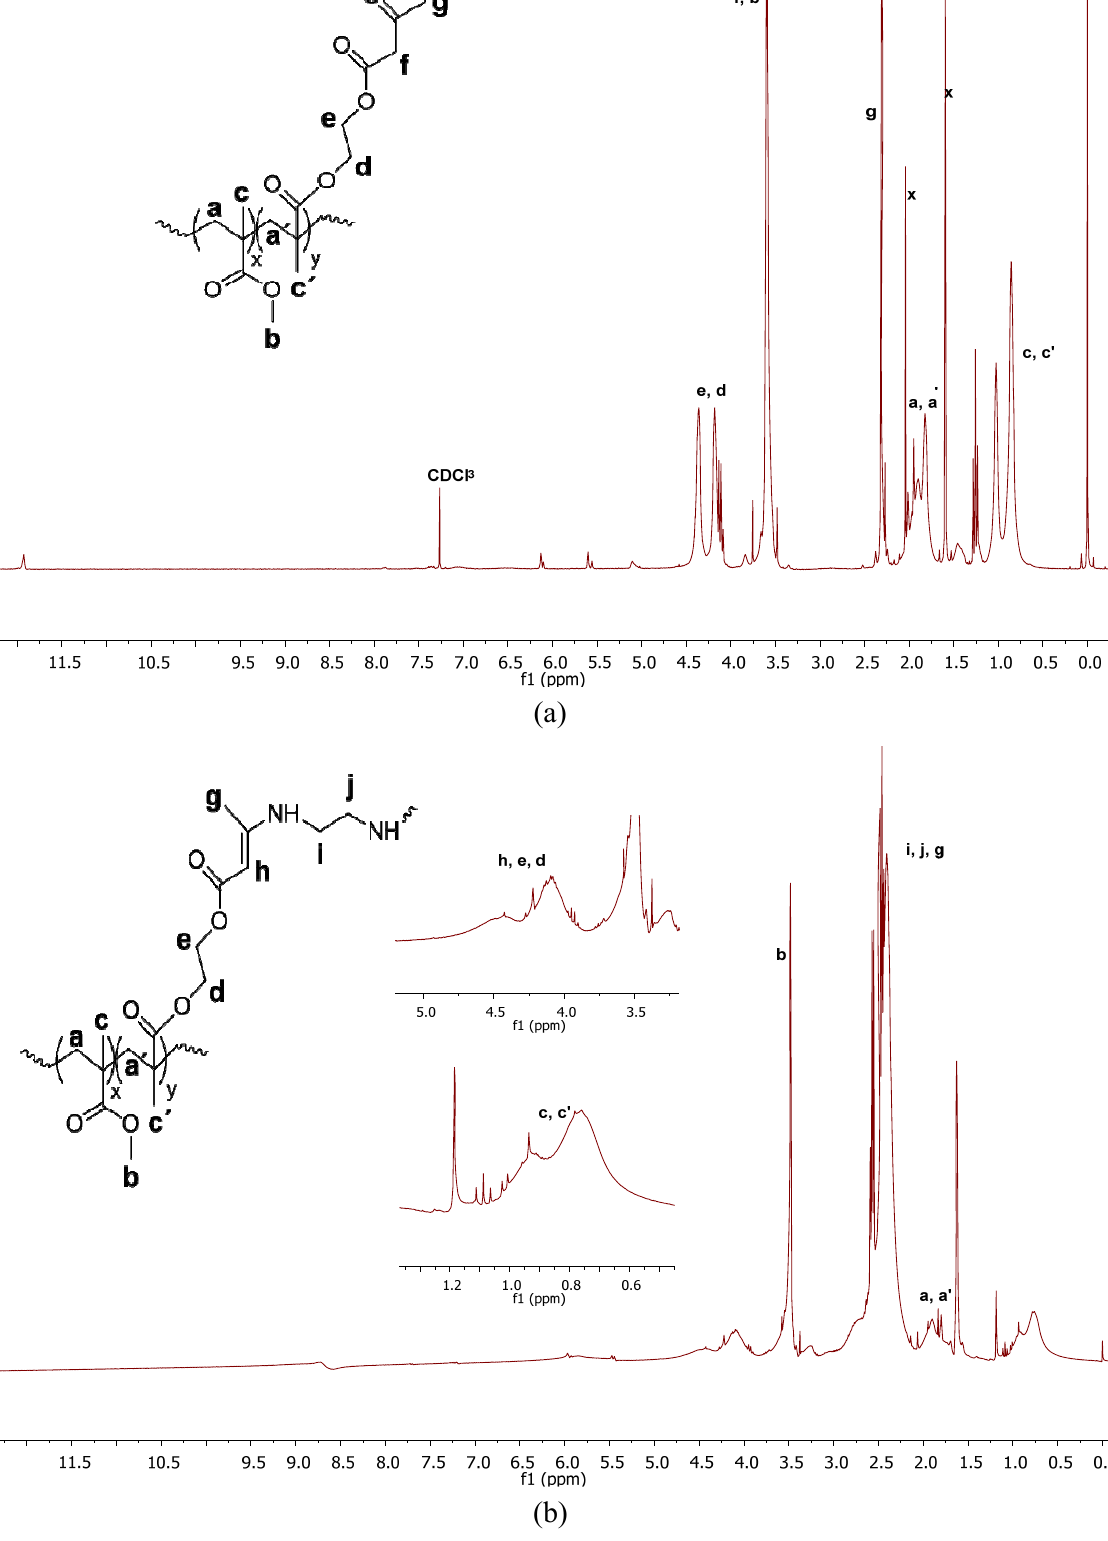
Figure 4. ( a ) 1 H-NMR spectrum of the starting P(MMA- co -AEMA) precursor 1a . ( b ) 1 H-NMR spectrum in tetrahydrofurane (THF)-d enamine “click” chemistry. The sharp, intense band around 1.7 arises from solvent (THF-d